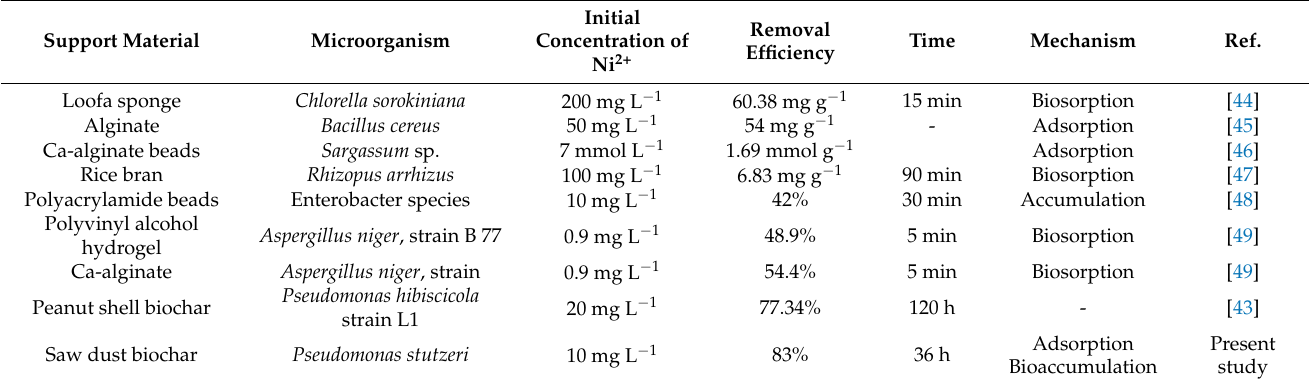
Table 4. Comparative data about Ni 2+ removal by microorganisms immobilized on various sup- port materials.